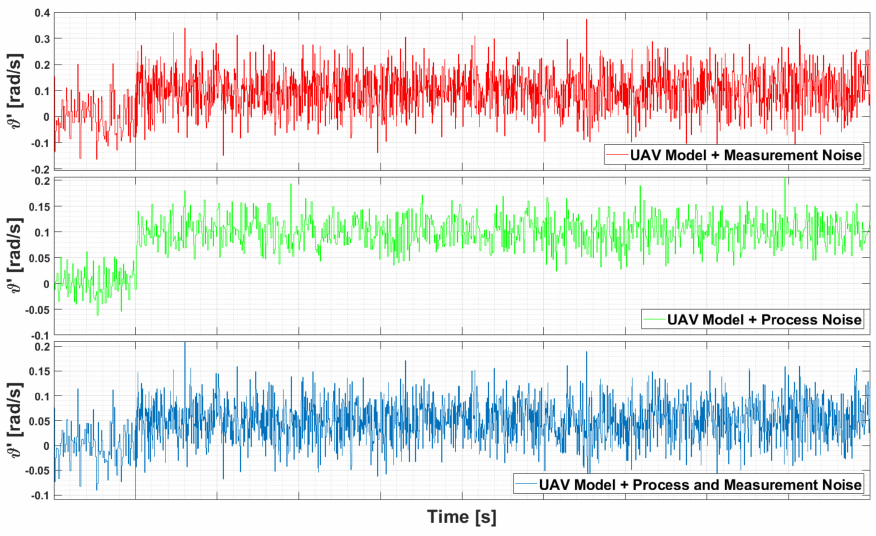
Figure 15. Graphical outputs of created UAV models including noises for a speed of 90